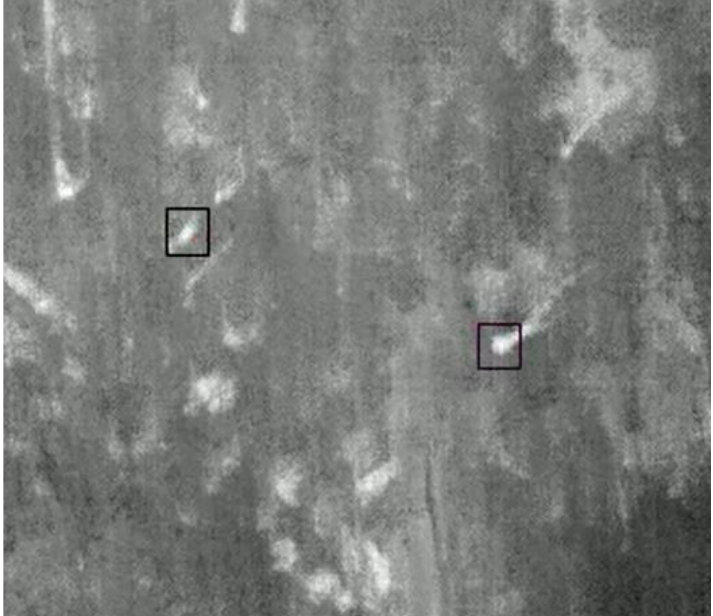
Figure 3. This frame shows the value of the ensemble’s ability to incorporate spatial dependencies. As these objects are tracked across frames, contextual clues will lower the confidence values of these tracks which will result in these objects, which are actually tree limbs, being discarded as possible koala detections.